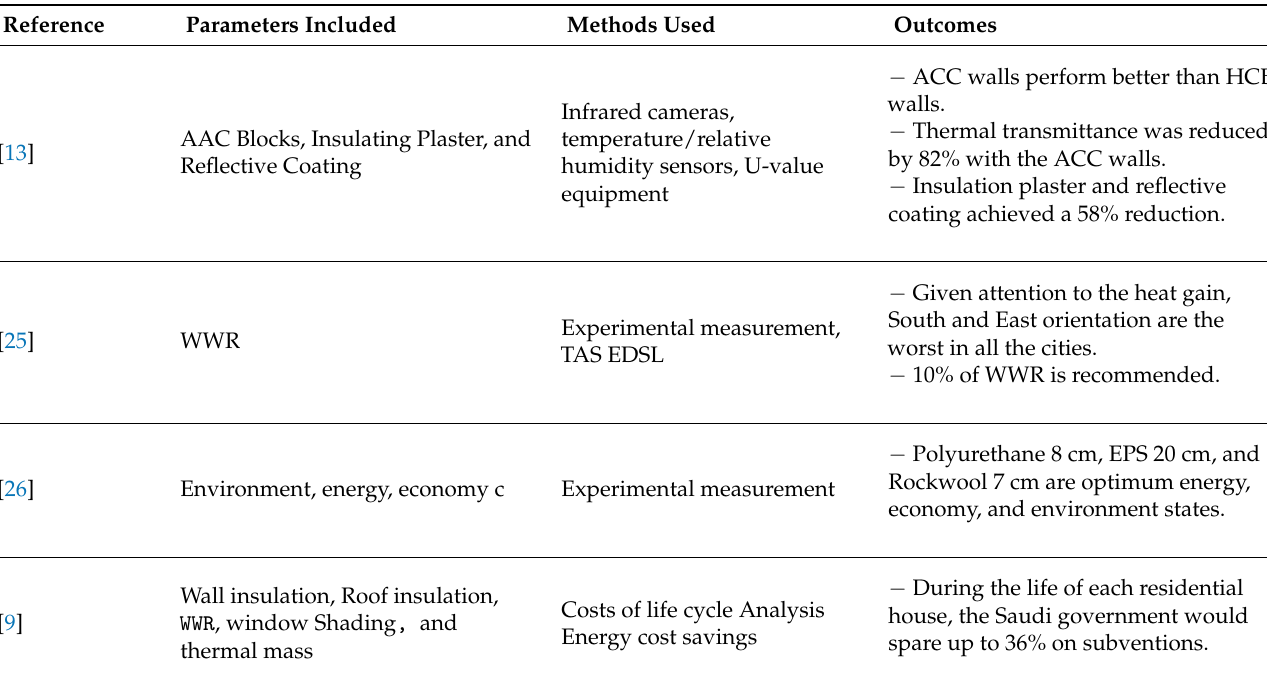
Table 1. Relevant past studies on wall envelope design impact on energy consumption and the LCA of wall insulation